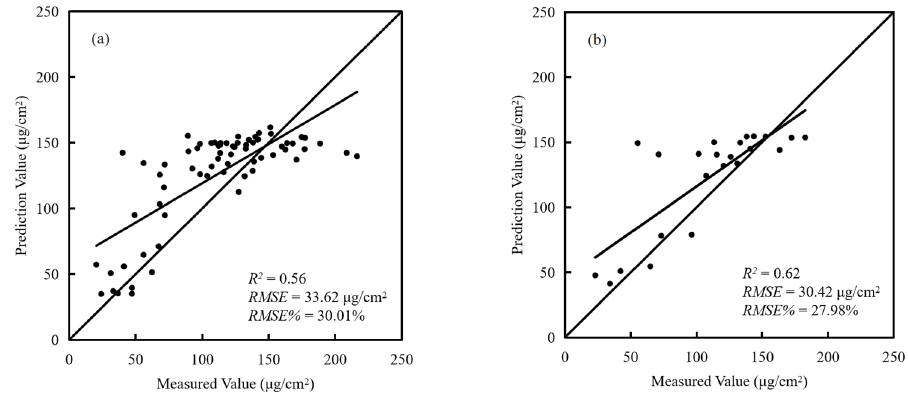
Figure 6. ANN model results. ( a ) Calibration; ( b ) Validation.